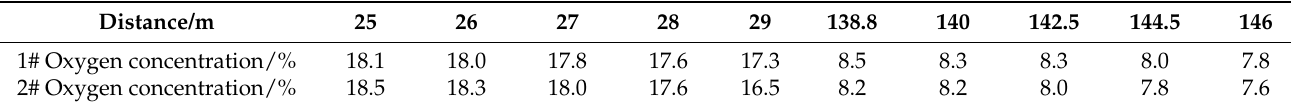
Table 3. Beam tube monitoring partial data.